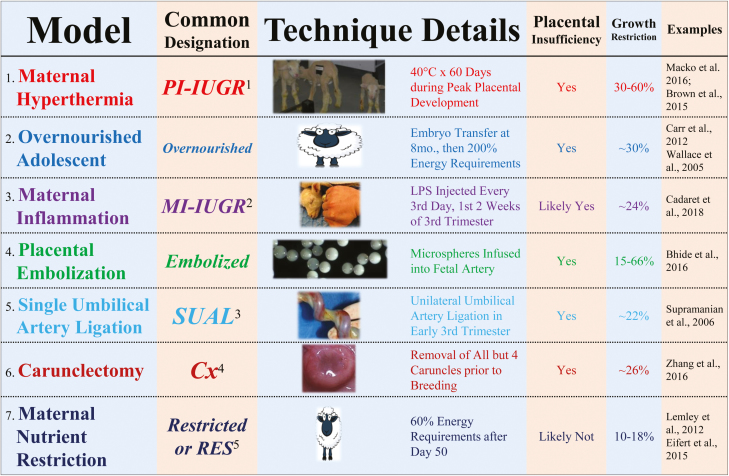
Sheep models that recapitulate the pathologies of IUGR humans. 1Placental insufficiency-induced intrauterine growth restriction (PI-IUGR). 2Maternal inflammation-induced intrauterine growth restriction (MI-IUGR). 3Single umbilical artery ligation (SUAL). 4Carunclectomy (Cx). 5Nutrient-restricted (RES).